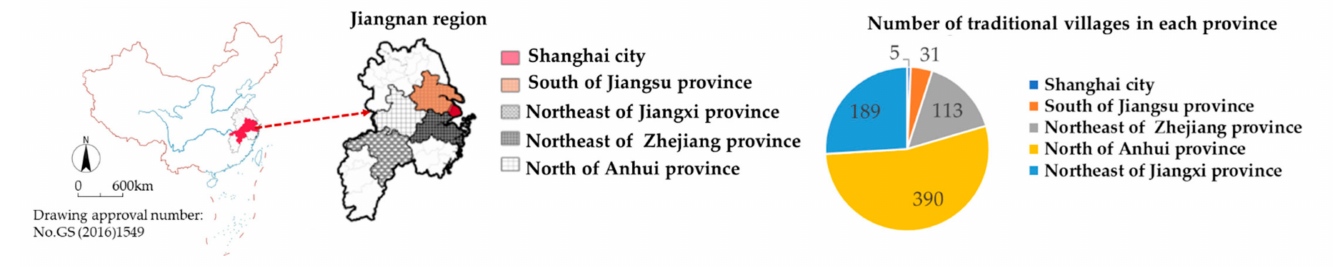
Figure 2. Research area and the number of villages: edited by